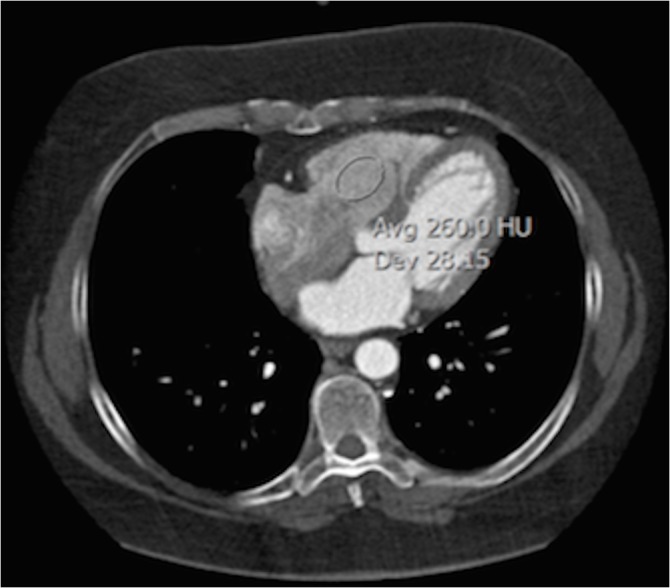
Contrast enhancement of the RV (260 HU) in CCTA.